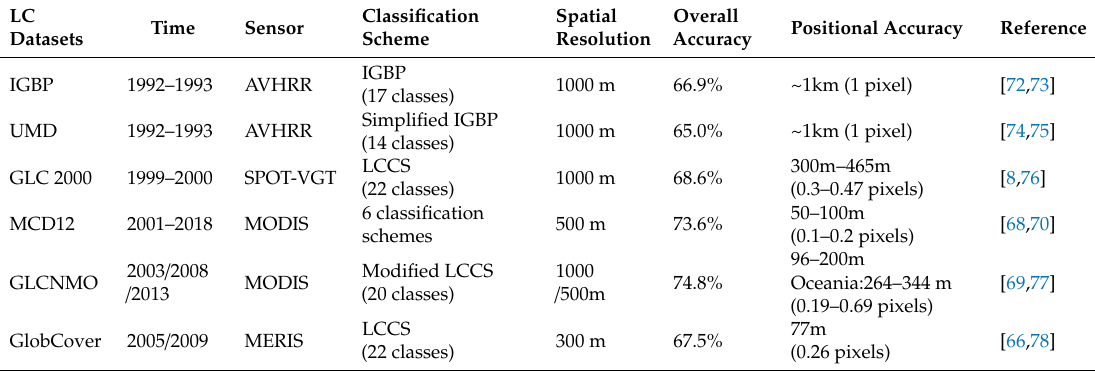
Table 7. Thematic accuracy and positional accuracy of the selected global land cover